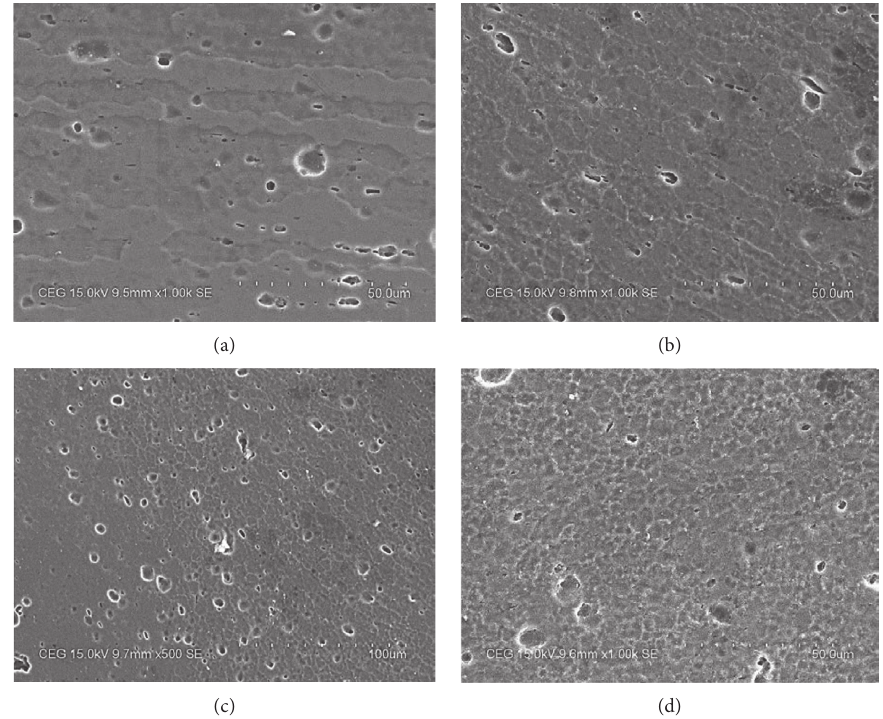
Figure 18: Detailed scanning electron microscopic image for dry friction stir welding of AA 7075 aluminium alloy. (a) Parent. (b) HAZ. (c) Interface. (d) Weld nugget